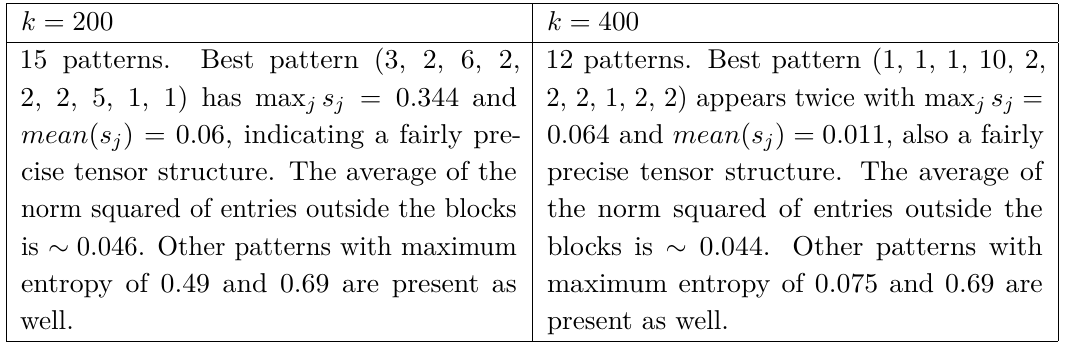
Table 4 . Almost- kaq ness for L 24 on su (5) . See remark 3.6 and section 3.2.3 for how to compute entropy s ( g, θ ) for C 2 ⊗ C 2 ⊕ C . Note that the average of a random entry from an l j 5 × 5 matrix is 0 . 04 (to be compared with above).